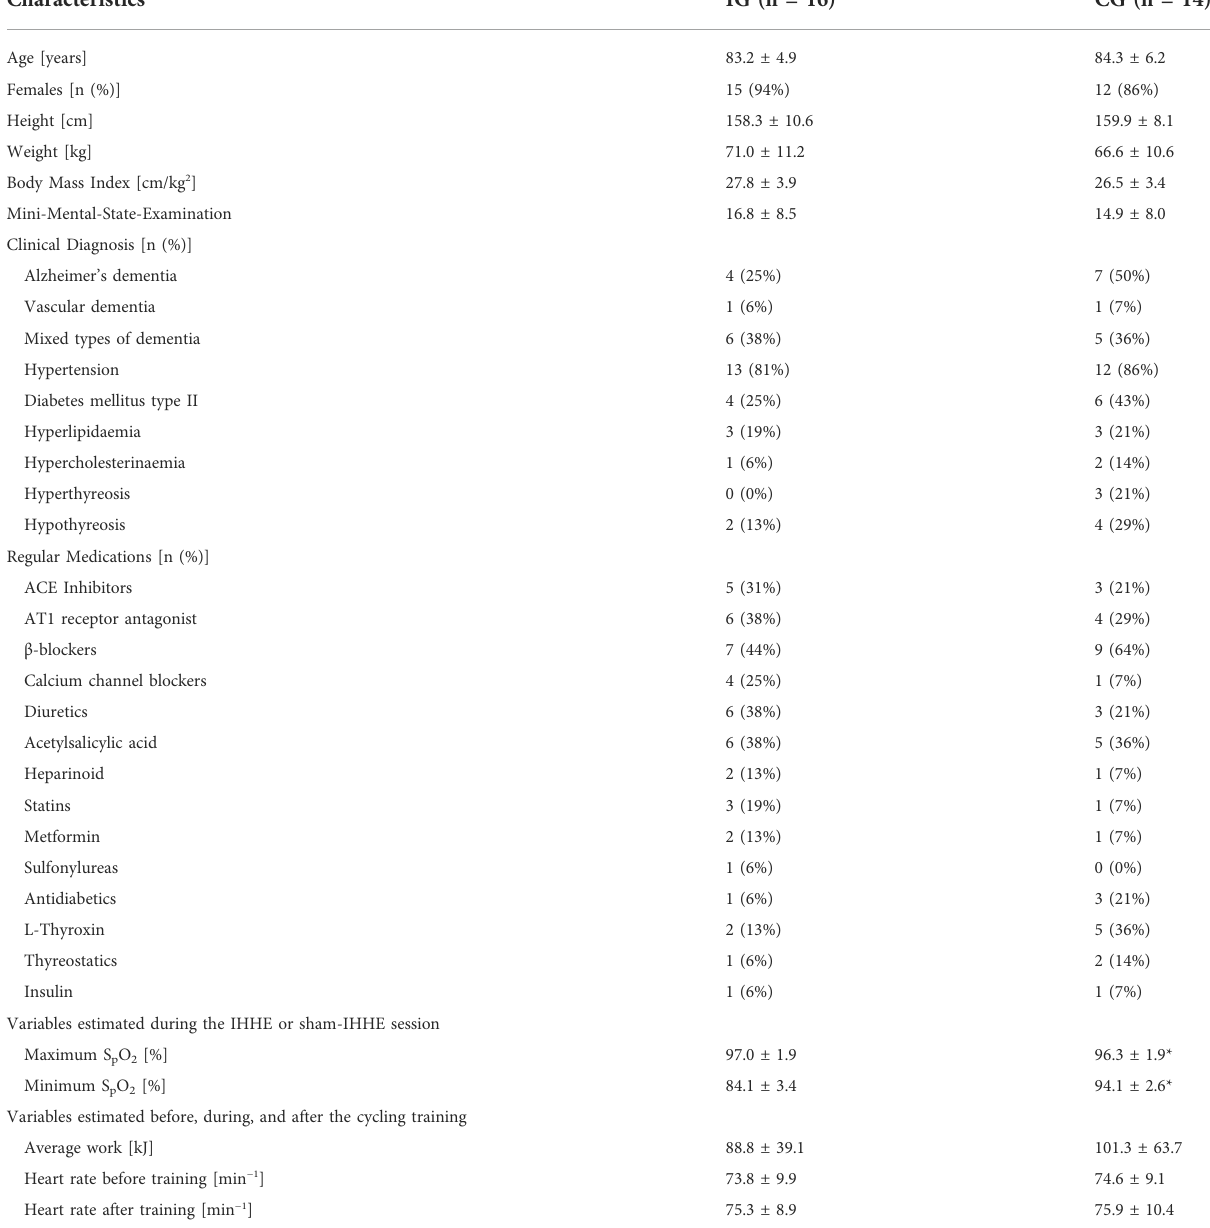
TABLE 1 Characteristics of the patients at baseline as well as training-related